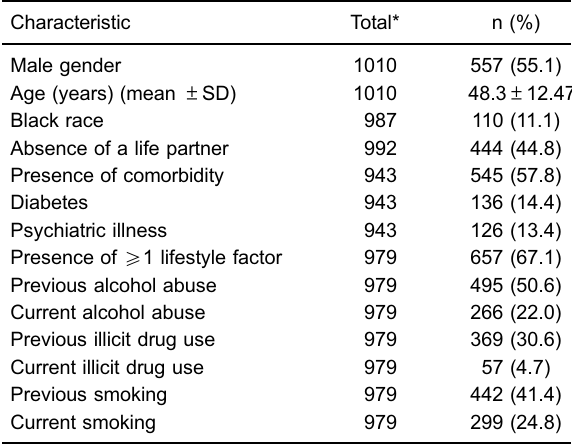
Table 1. Characteristics of the 1010 anti-HCV-positive